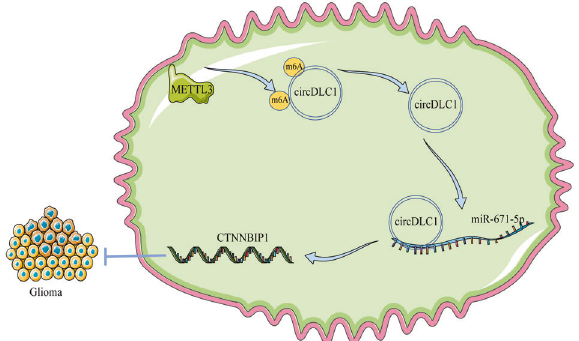
Fig. 8 Molecular mechanism of circDLC1 regulating malignant proliferation of glioma cells. METTL3-mediated m 6 A modi fi cation can increase the stability of circDLC1, upregulate the expression of circDLC1 in glioma cells, and promote the competitive binding of circDLC1 and miR-671-5p, thereby upregulating the transcription of CTNNBIP1 and then inhibiting the malignant proliferation of glioma